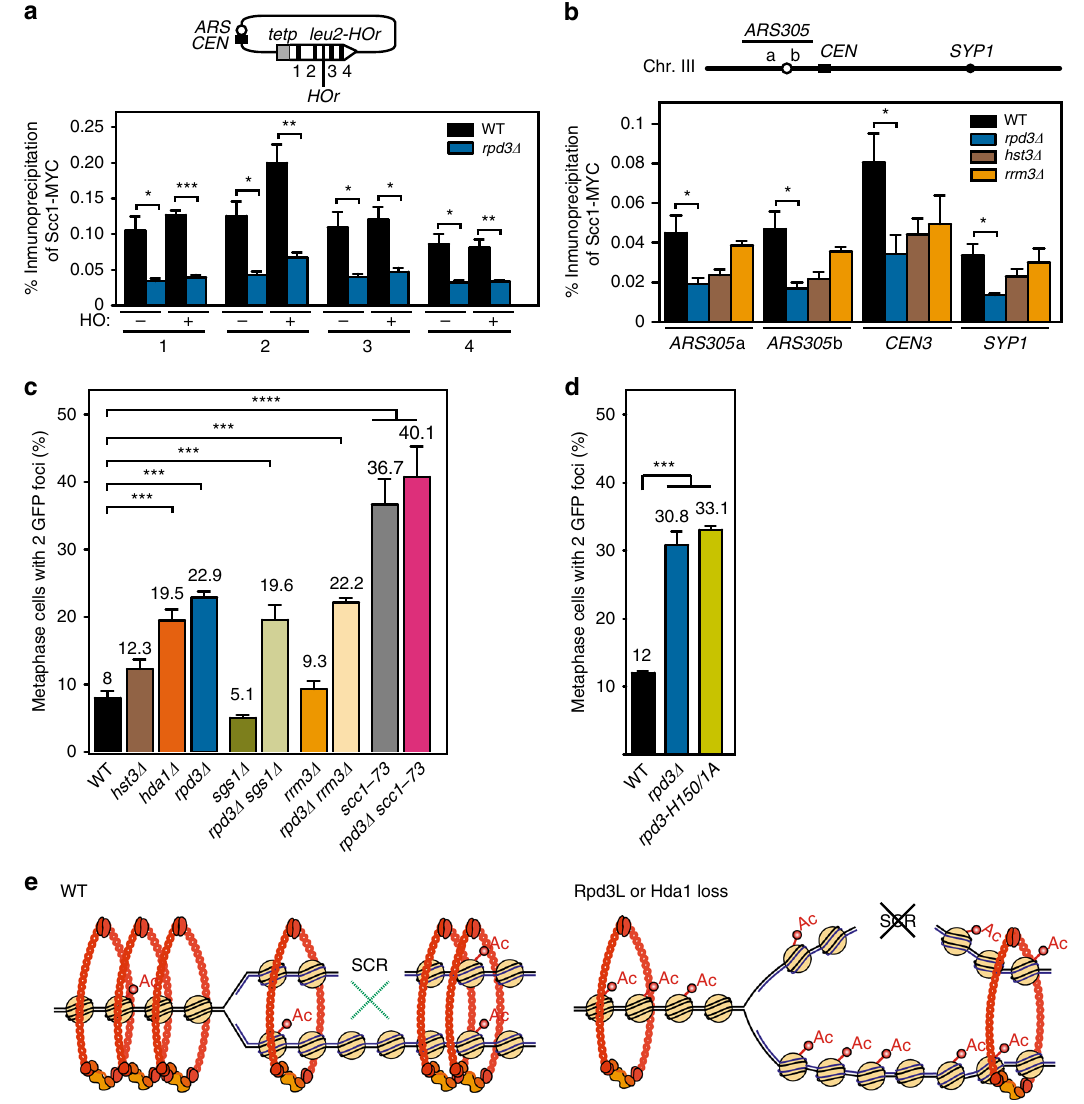
Fig. 7 Rpd3 and Hda1 promote cohesin loading and sister chromatid cohesion. a ChIP analysis of Scc1-MYC occupancy in wild type (WSM) and rpd3 Δ (WSMR3) strains after glucose ( − HO) or galactose ( + HO) addition for repression or activation of the HO endonuclease. A scheme of the different regions analyzed along the leu2 gene of pCM189-L2HOr is depicted on top ( n ≥ 3). b ChIP analysis of Scc1-MYC occupancy in wild type (WSM), rpd3 Δ (WSMR3), hst3 Δ (WSMH3), and rrm3 Δ (WSMRR) strains. A scheme of the different chromosome III regions analyzed is depicted on top ( n ≥ 3). c Percentage of G2 (nocodazol) arrested cells that have lost sister chromatid cohesion at centromere III, as indicated by the appearance of 2 GFP foci, in wild type (SBY885), hda1 Δ (SBHDA1), rpd3 Δ (SBRPD3), hst3 Δ (SBHST3), sgs1 Δ (SBSGS1), rpd3 Δ sgs1 Δ (SBR3SG), rrm3 Δ (SBRRM3), rpd3 Δ rrm3 Δ (SBR3RR), scc1-73 (SBSCC1), and rpd3 Δ scc1-73 (SBR3S1) ( n ≥ 3). d Percentage of G2 (nocodazol) arrested cells that have lost sister chromatid cohesion at centromere III, as indicated by the appearance of 2 GFP foci, in SBRPD3 ( rpd3 Δ ) strain transformed with PEN149 (WT), pRS315 ( rpd3 Δ ), or PEN153 ( rpd3-H150/1A ) plasmids ( n =